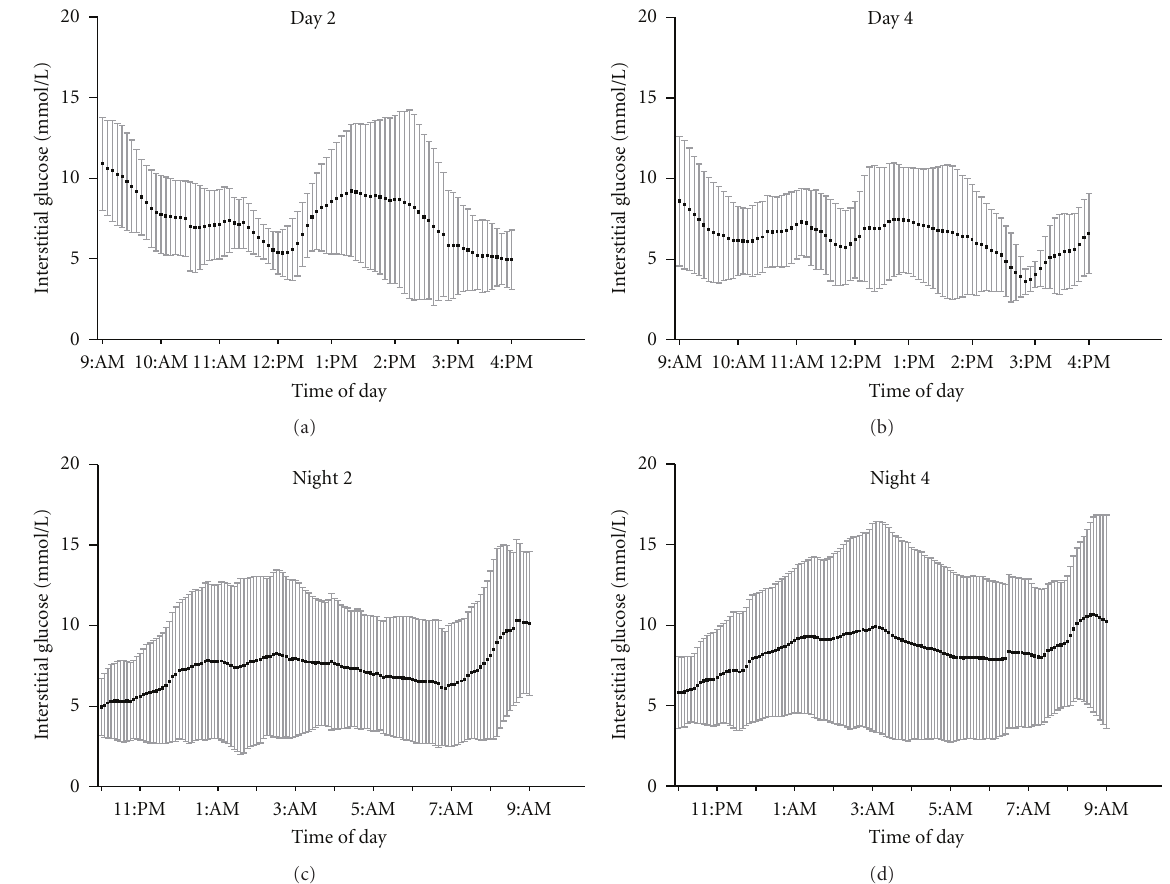
Figure 2: Interstitial glucose levels during day 2 ((a) n = 8) day 4 ((b) n = 10), evening 2 ((c) n = 8), and evening 4 ((d) n = 10) of the sports camp. Mean ± SD.